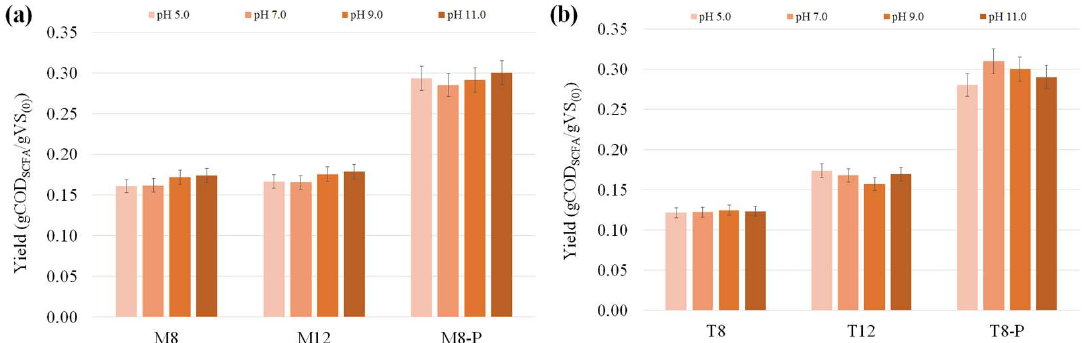
Figure 4. Fermentation yield values (Y F ; g COD SCFA /g VS 0 ) in the mesophilic batch series M8, M12, and M8-P ( a ); fermentation yield values (Y F ; g COD SCFA /g VS 0 ) in the thermophilic batch series T8, T12, and T8-P ( b ).